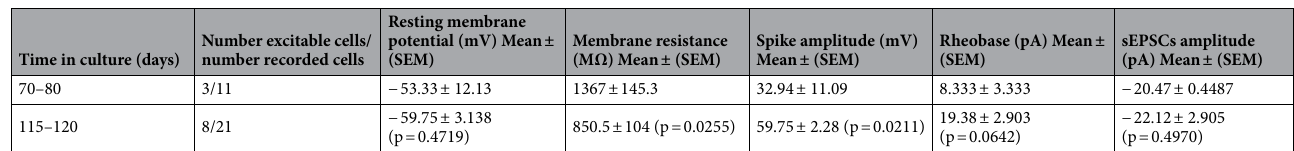
Table 1. Electrophysiological properties of patched cells across time in culture. Summary of electrophysiological characteristics of excitable cells in cerebral spheroids recorded with whole-cell recordings. Student’s t